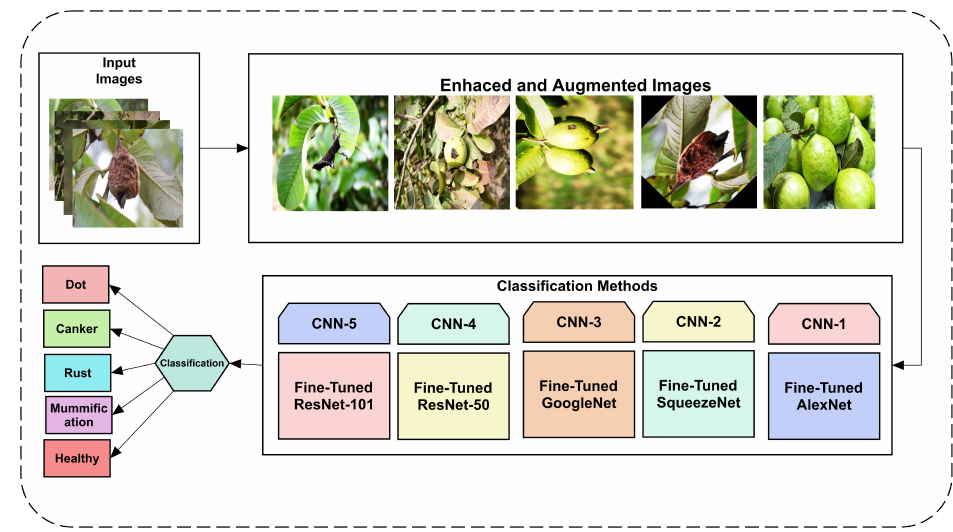
Figure 1. Proposed framework for guava plant disease detection.